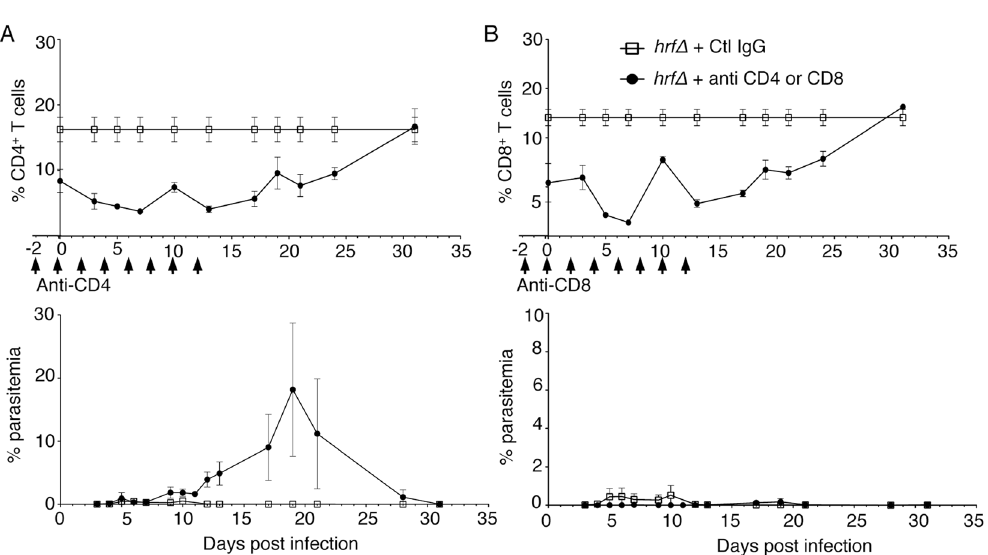
Figure 4. Influence of CD4 + or CD8 + T cells depletion on parasite development in protected mice. Pb NK65 hrf Δ iRBCs-protected mice were treated either with IgG or with anti-CD4 − ( A ) or with anti-CD8-depleting Abs ( B ) 2 days prior to a challenge with 10 5 iRBCs WT parasites followed by 7 injections of IgG, anti-CD4 or anti-CD8 Abs administered every other day after the infection. Anti-CD4 and CD8 treatment was discontinued at day 12 p.i. Parasitemia as well as determination of cell counts in the blood were recorded over time. Error bars, SEM. Data are representative of two independent experiments with 5 mice per